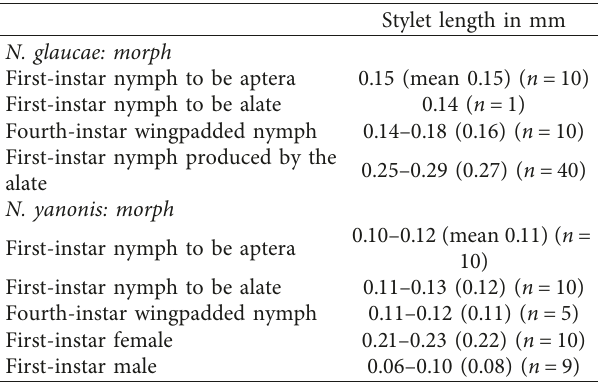
Table 5: Approximate length of the stylets of Neothoracaphis glaucae and N. yanonis